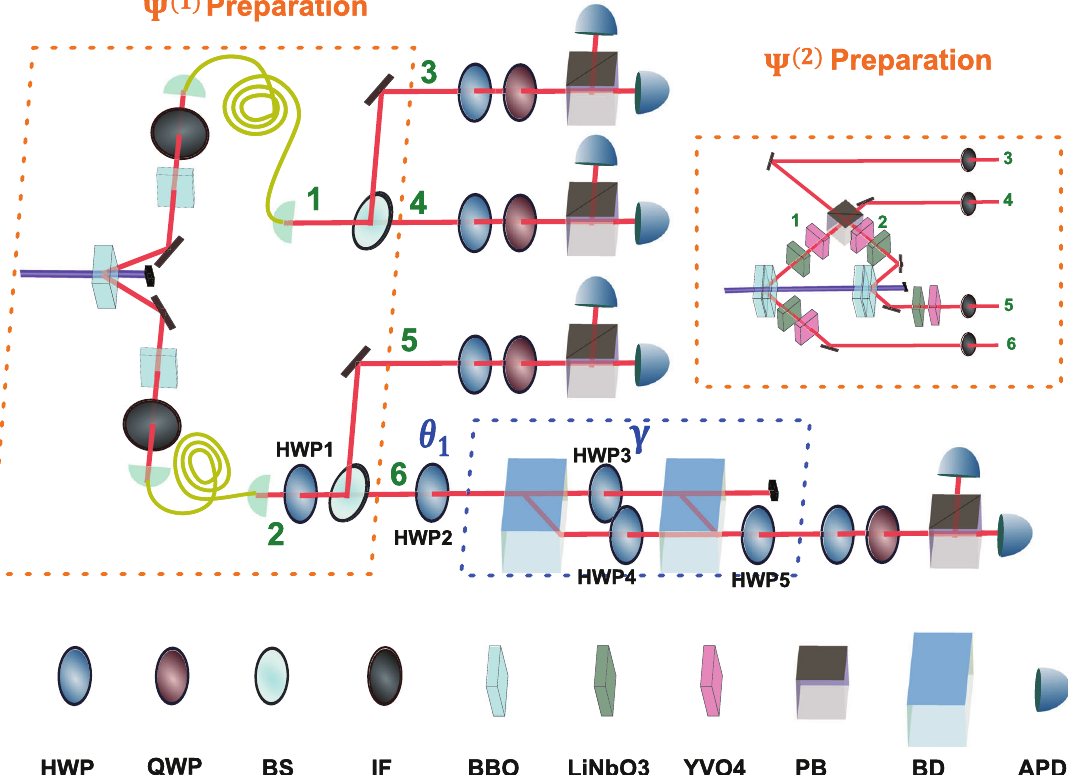
Fig. 5 Experimental set-up. Detailed con fi gurations for preparing the states | Ψ (1) 〉 and | Ψ (2) 〉 and for realizing the operator A γ are shown in the is realized by HWP2 at speci fi c angles. A quarter-wave plate (QWP) and a half-wave plate (HWP) corresponding boxes. The unitary operator U ϑ 1 in front of a polarization beam splitter (PBS) in each mode are used to implement the measurement in different bases for the standard state tomography. All the photons are detected by avalanche photo-diodes (APD). Post-selection in some basis of qubit 1 (the state of the photon in mode ‘ 3 ’ ) is realized by collecting only photons in one of the output modes of the PBS. The indices in the fi gure denote the spatial